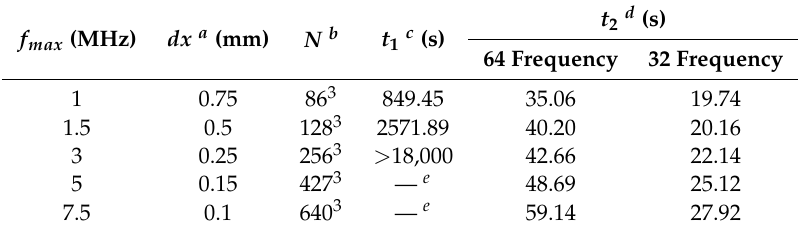
Table 5. Running time of k-Wave and the proposed method for different maximum frequency supported by grid size in k-Wave and two different number of frequencies modeled by our method.